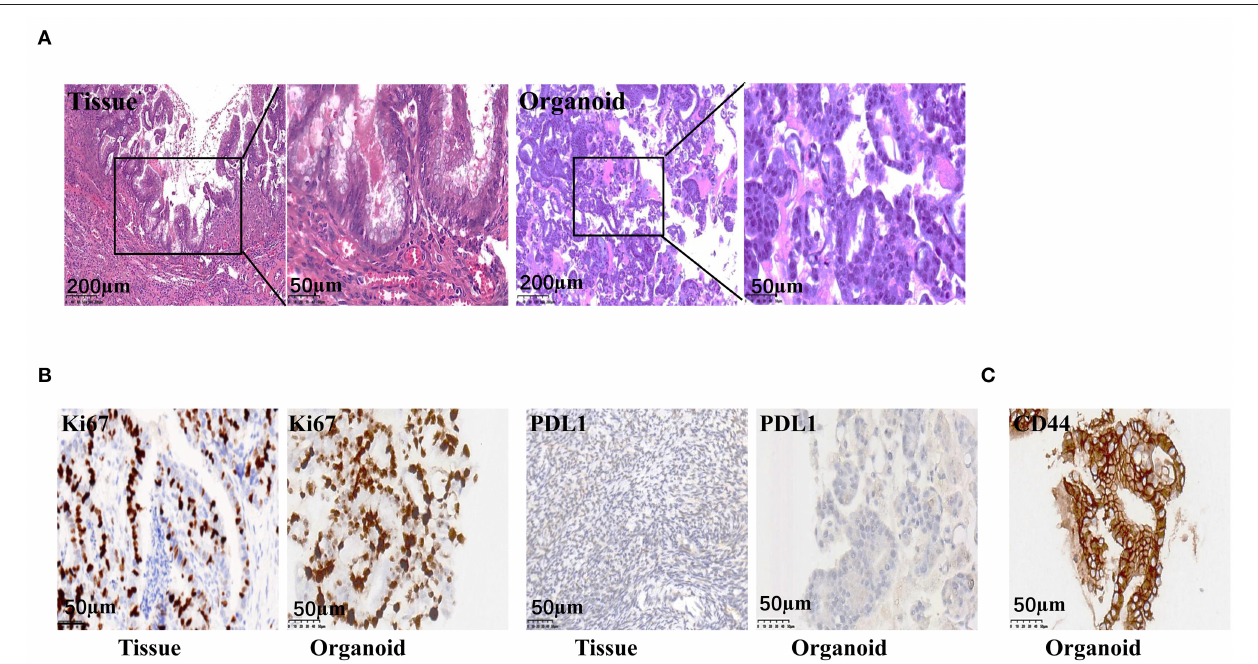
FIGURE 2 | Representative images of the pathological staining of MAA. (A) H&E staining of the organoid (passage 8) and the original tumor. (B) Immunohistochemistry staining of the original tumor and the organoid (passage 8) for Ki67 and PDL-1. (C) Immunohistochemistry staining of the organoid (passage 8) for CD44.